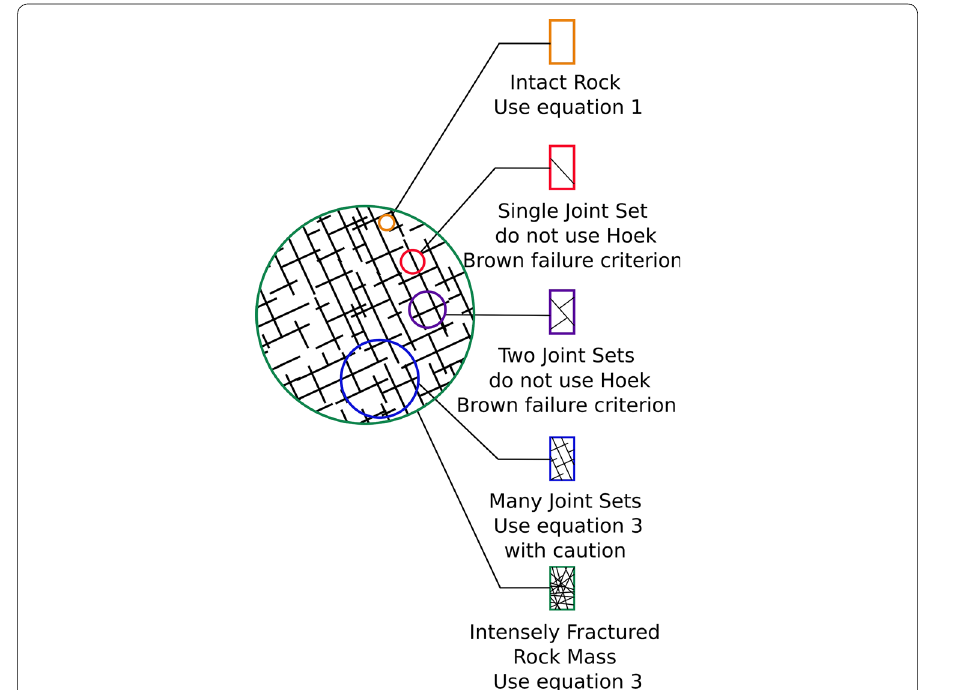
Fig. 4 Schematic of conditions under which the Hoek–Brown failure criterion is valid (Modified from Hoek et al.